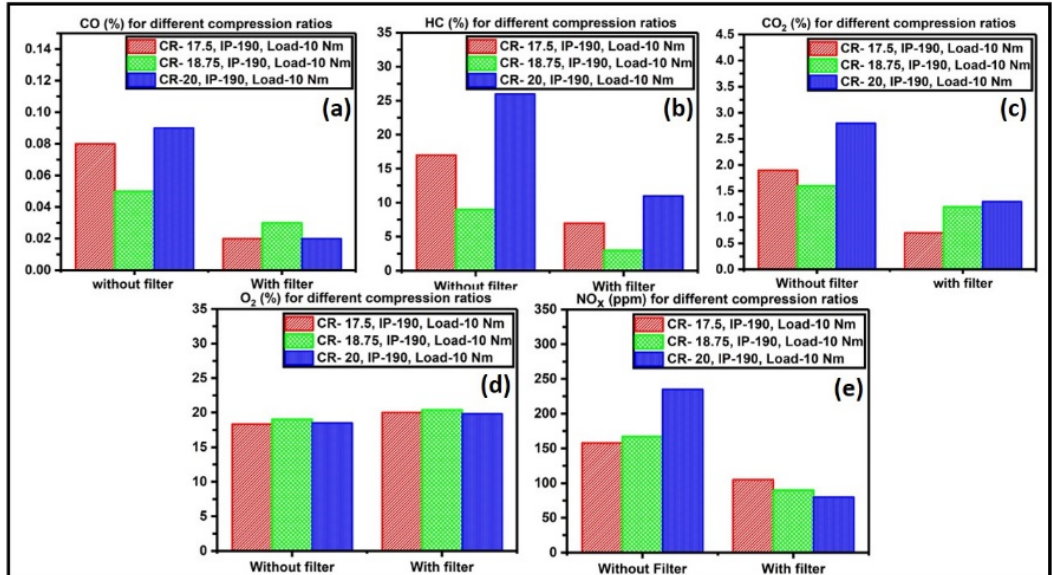
Figure 8. ( a ) CO emission, ( b ) HC emission, ( c ) CO 2 emission, ( d ) NO x emission, and ( e ) O 2 emission recorded when CR = 17, 18.75, and 20; IP = 190 bar; load = 10 Nm. Figure 9a–e exhibit the emission results of the second test cycle accomplished by varying the injection pressures to 190, 205, and 220 bar, while keeping the CR and load at constant values of 18.75 and 15 Nm, respectively. The lower IP value of 190 bar shows the higher emissions, but the catalyst filters drastically reduce the emissions. The emission reduction in CO, HC, CO 2 , and NO x in this test cycle was 82%, 62%, 83%, and 47%, respectively. These reductions were good only at higher IP values. So when the IP is high, it facilitates the redox mechanisms of the exhaust soot.